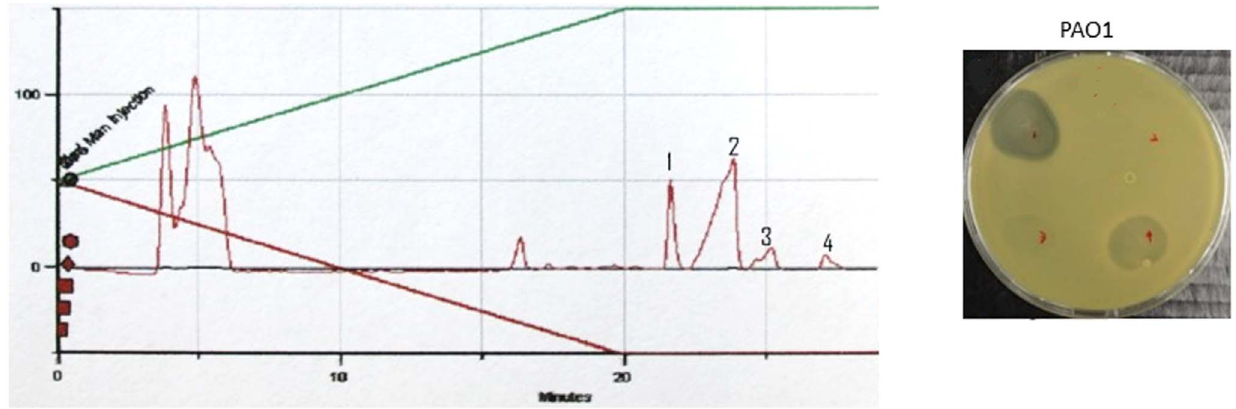
Figure 5. Fractionation of the antagonistic activity by HPLC. HPCL fractionation of a crude extract from a culture supernatant of P. putida W15Oct28 grown in M9-glucose medium: A, chromatography of crude extraction of W15Oct28 cultured in M9 minimal medium for 48 hours; B, chromatography of crude extraction of W15Oct28 cultured in M9 minimal medium for 48 hours plus 5 days stay at 6 u C. The yield of fraction 1 and 4 were increased with longer time of cultivation. Fractions 1 to 4 were spotted on an agar plate inoculated with P. aeruginosa PAO1 (upper left, fraction 1, upper right, fraction 2, lower left, fraction 3, lower right, fraction 4). The green line represents the acetonitrile gradient.